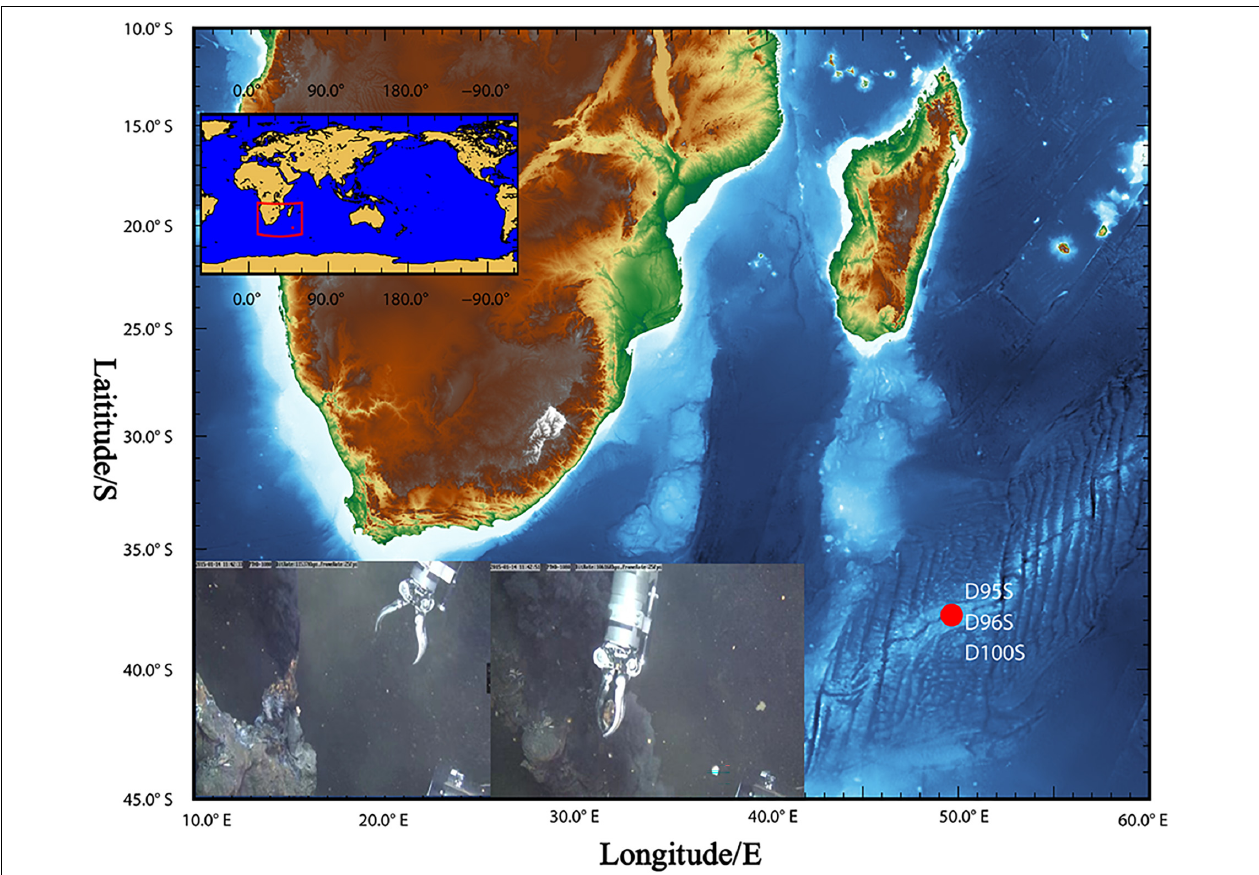
FIGURE 1 | Sampling site at “Longqi” hydrothermal field. During R/V DY35, two chimney rocks (D96S and D100S) were obtained by the “Jiaolong” submersible from active sulfide chimney bodies (inset figures) at “Longqi” hydrothermal field in the Southwest Indian Ocean. A sulfide sample (D95A) was also collected from a nearby inactive chimney by the submersible. The details of the samples are listed in Supplementary Table 1